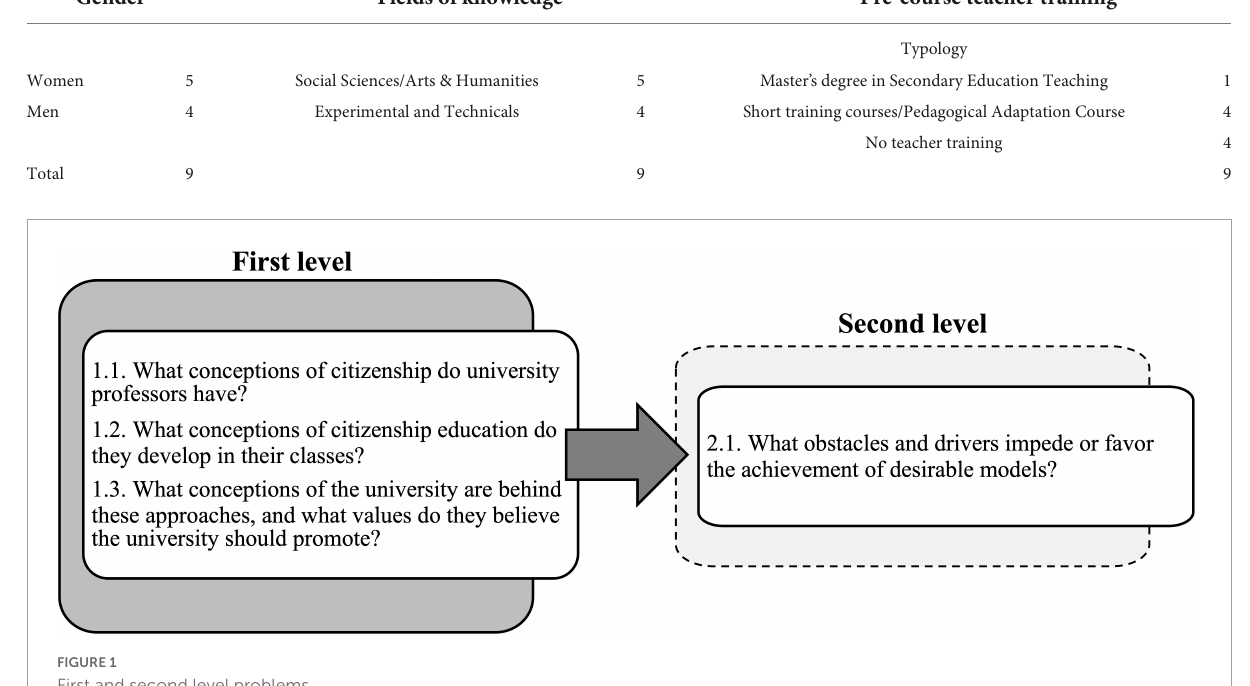
TABLE 1 Characteristics of participants.